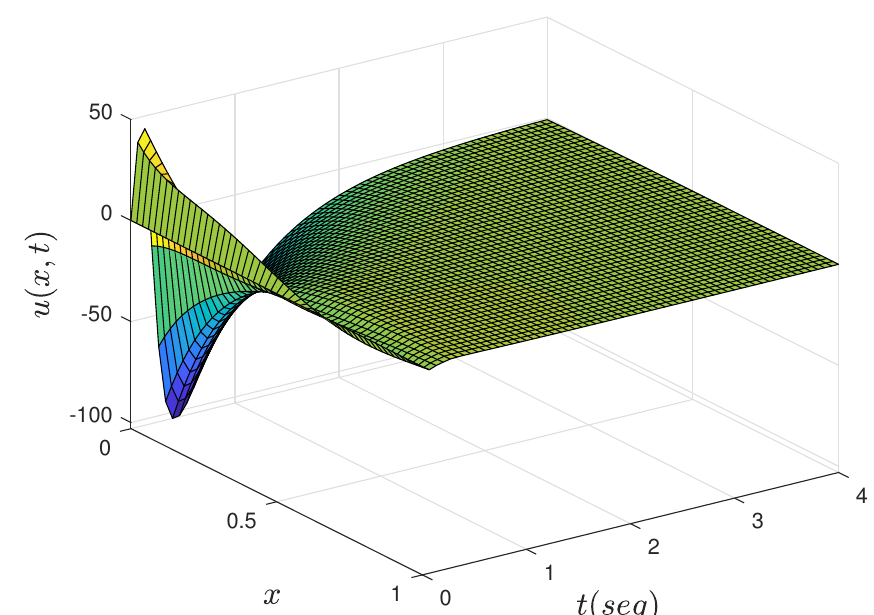
Figure 8. Performance in closed-loop of the adaptive Neumann stabilizing controller.